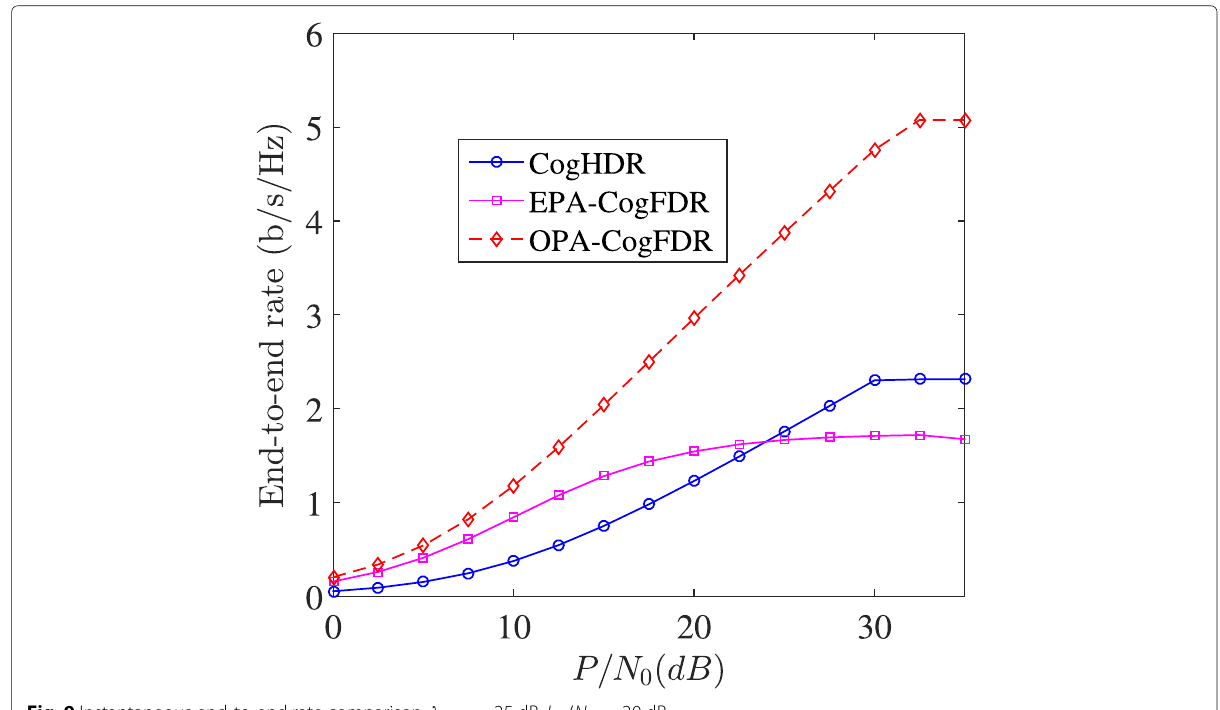
Fig. 9 Instantaneous end-to-end rate comparison; λ rr = − 25 dB, I th / N 0 = 20